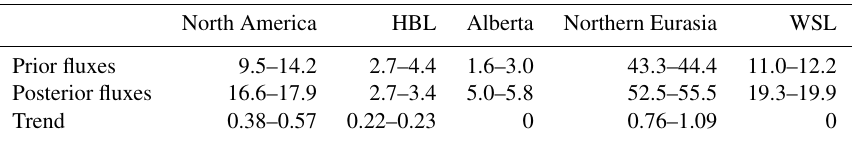
Table 4. Summary showing the range of the prior and posterior estimates from scenarios S1 and S2 for the mean fluxes (Tgyr − 1 ) for 2005–2010 (as given in the text) and the trend (Tgyr − 2 ) over